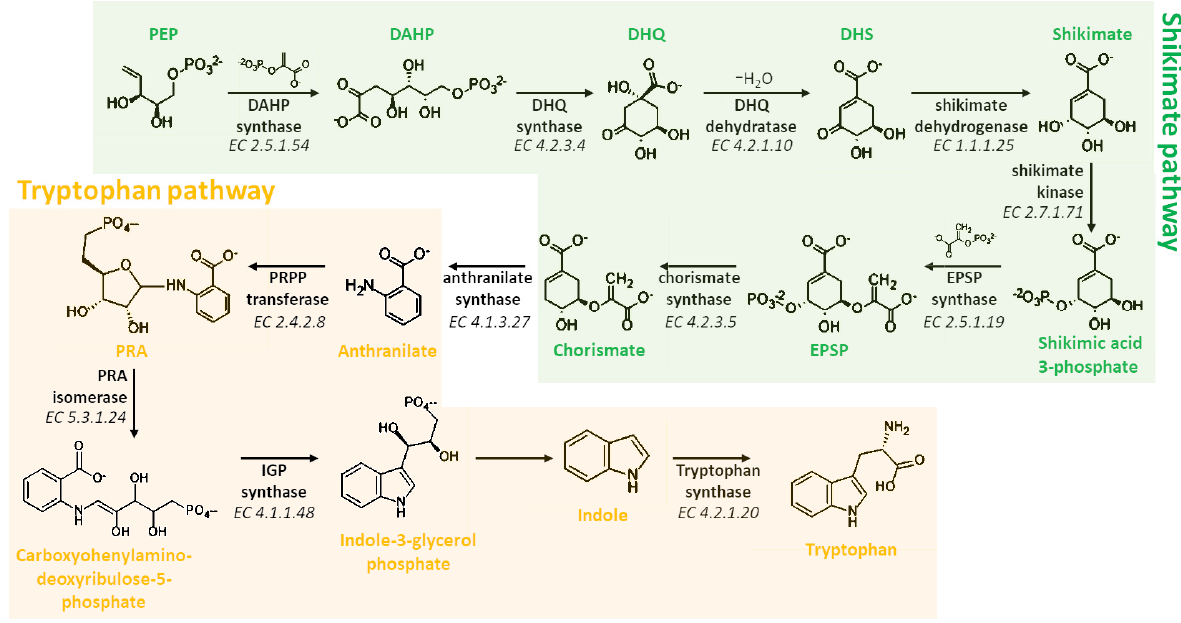
Figure 3. Biosynthetic pathway involved in the synthesis of tryptophan, the key compound for the formation of melatonin in plants. PEP: 2-phosphoenolpyruvate; DAHP: 3-deoxy-D-arabinoheptulosonate 7-phosphate; DHQ: 3-dehydroquinic acid; DHS: 3-dehydroshikimate; PEP: 2-phosphoenolpyruvate; EPSP: 5-enolpyruvylshikimate-3-phosphate; PRA: Phosporibosyl antranilate; PRAI: PRA isomerase; PRPP: phosphoribosylpyrophosphate; IGP: indole-3-glycerol phosphate; EC: enzyme commission number).